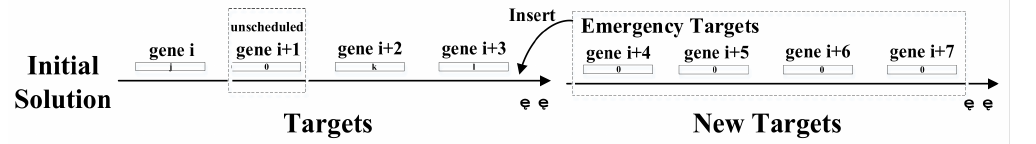
Figure 3. Emergency targets inserted into the initial solution.